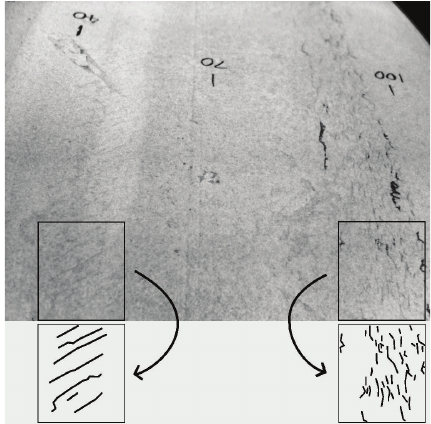
Figure 4: Two bands of cracks on surface of wheel, highlighted with dye penetrant. The flange is to the left and the field side to the right. Inverted numerals (40, 70, and 100) indicate distance from the back of the flange in millimetres. A manually enhanced sample of each crack band is shown below the original in the boxes. Flange root (Region C, left) has long angled surface cracks. Field side band (RegionE,right)hascircumferentialcracks;someofthesearelonger and penetrate more